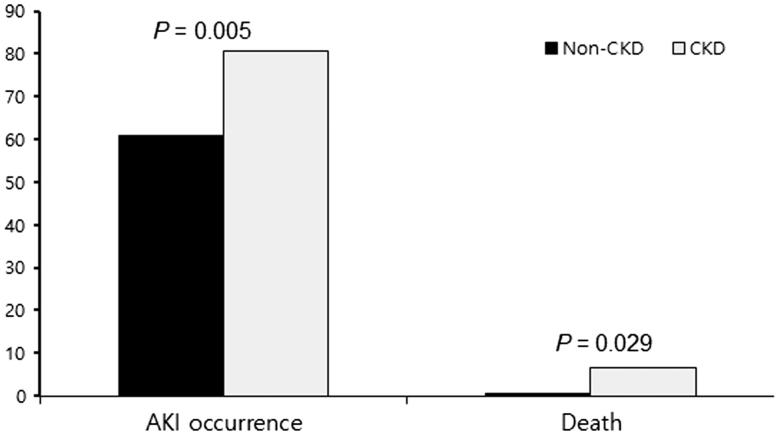
Percentage of AKI occurrence and death according to presence of CKD.